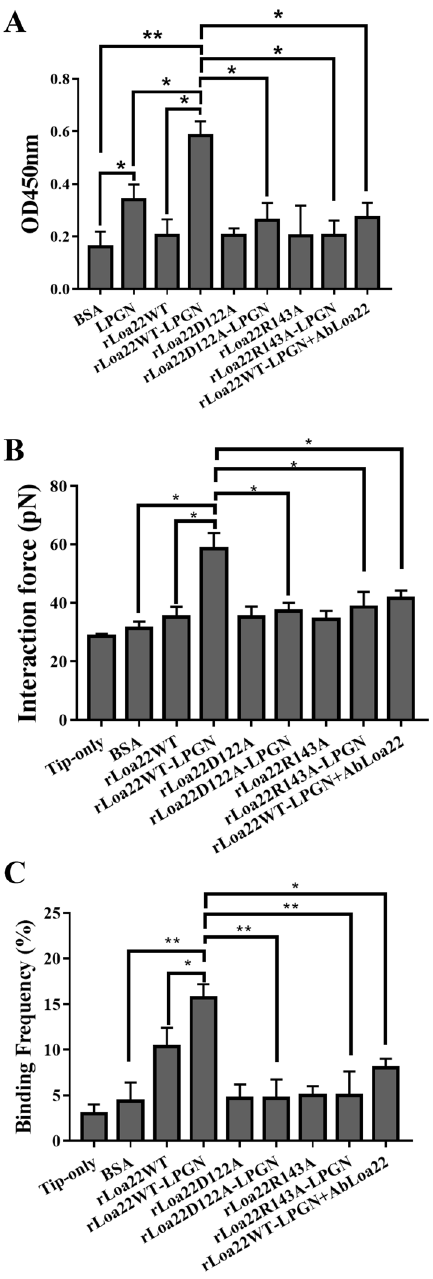
Figure 4. In vitro assay of the interaction between TLR2 and rLoa22-LPGN complexes. ( A ) ELISA assay of the interaction between TLR2 and rLoa22. ( B ) AFM force-distance curves of the interaction between TLR2 and rLoa22. ( C ) The binding frequency of the interaction between TLR2 and rLoa22. TLR2 interacted to rLoa22WT and mutation variants, rLoa22D122A and rLoa22R143A in the presence or absence of LPGN. BSA was used as negative control. ⃰ p < 0.05; ⃰ ⃰ p <